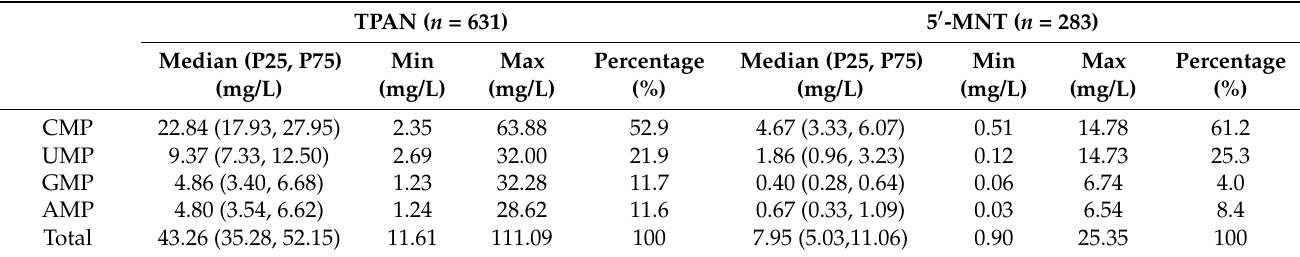
Table 2. The TPAN and 5 (cid:48) -MNT contents in mature